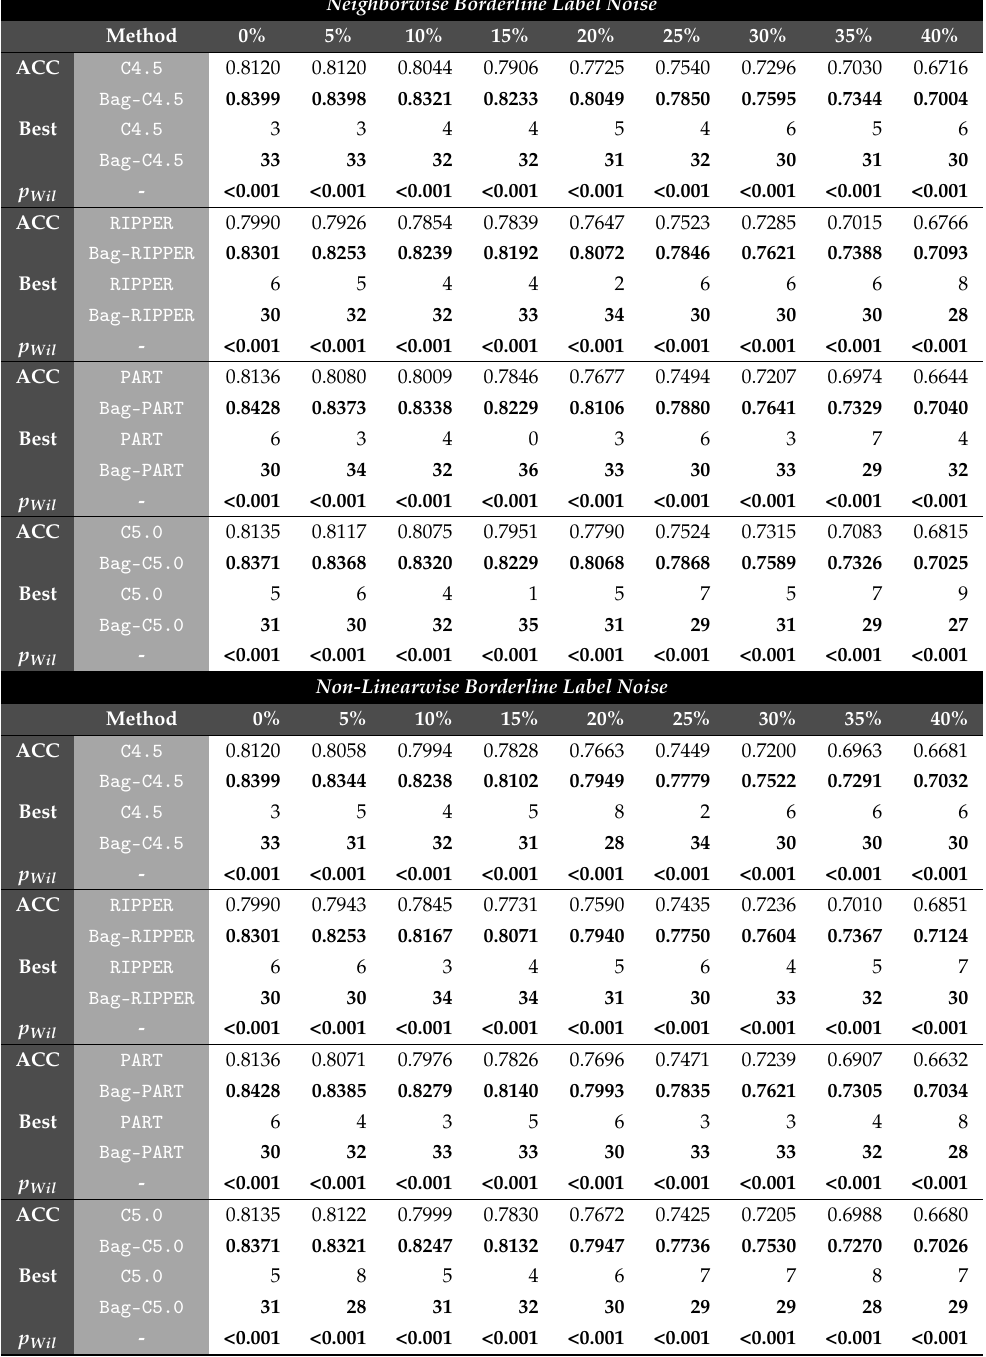
Table 2. Accuracy results of baseline and bagging classifiers with borderline label